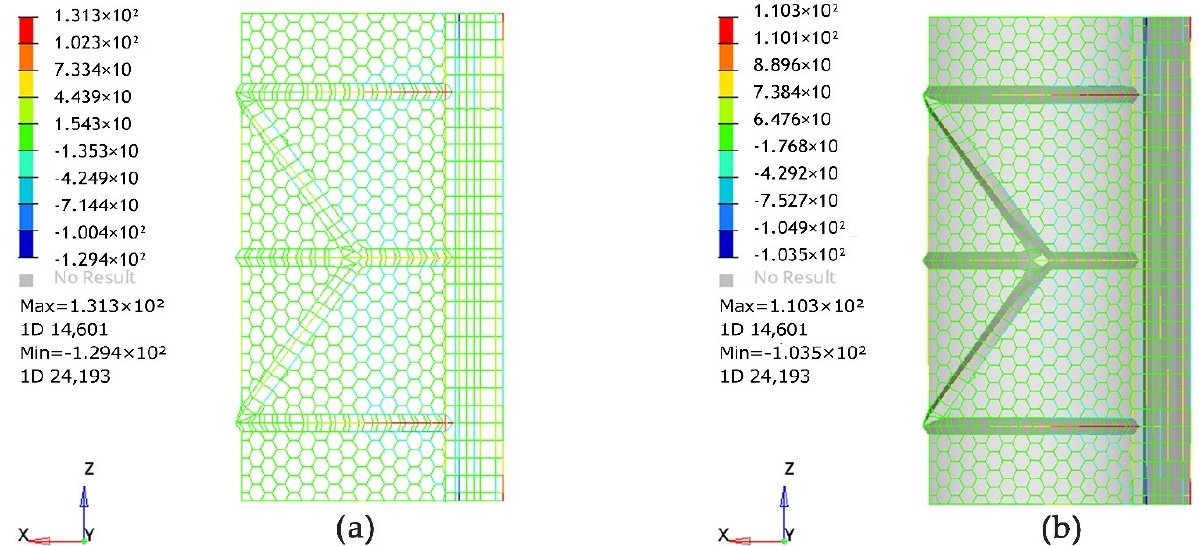
Figure 11. Stress diagram of model I rod under the action of permanent load plus external load. ( a ) Numerical diagrams of maximum tensile and compressive stresses for model I skeleton under self-weight plus external load. ( b ) Numerical diagram of maximum tensile and compressive stresses in model one skeleton with membrane cloth under self-weight plus external load.